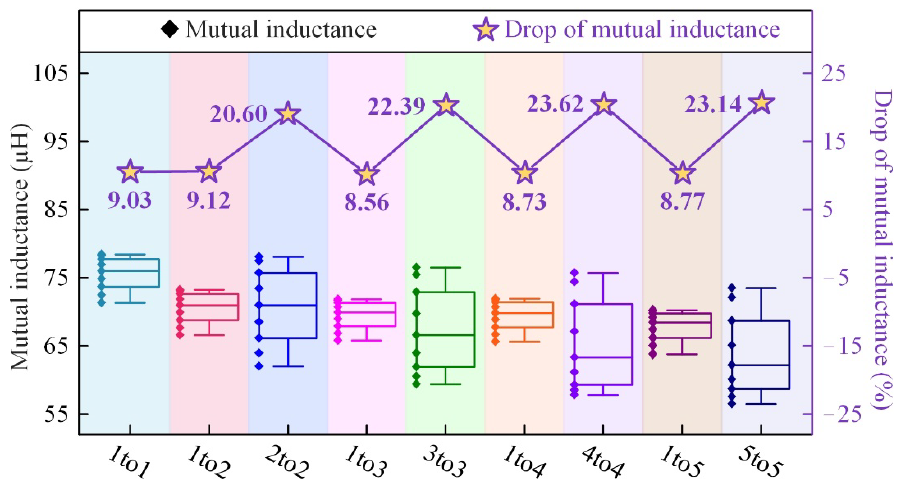
Figure 8. Comparison of different coil structures using the distribution characteristics of mutual inductance versus 0-to-100 mm horizontal misalignment.